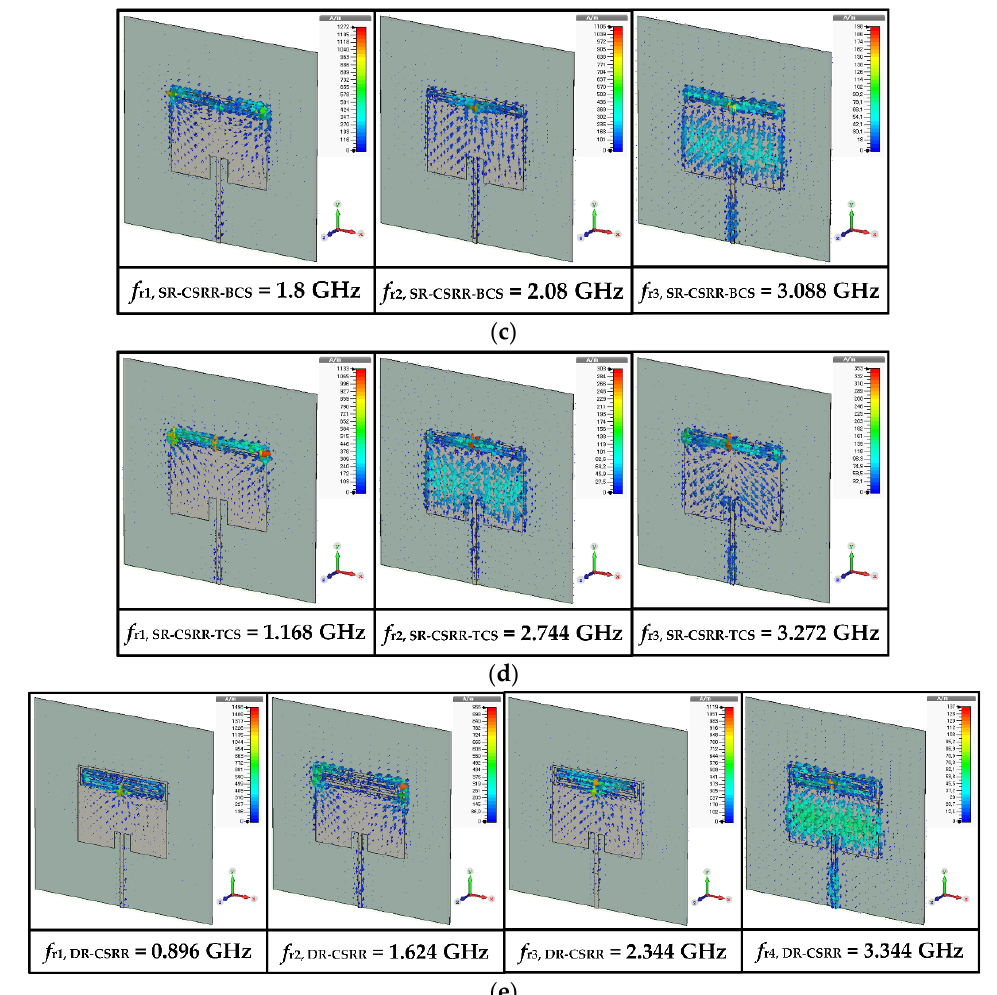
Figure 4. Simulated surface current distributions of the reference and four slot ‐ loaded MPAs at the resonant frequencies with a broadside direction (+ z axis) radiation patterns: ( a ) the reference MPA, ( b ) the RS ‐ loaded MPA, ( c ) the SR ‐ CSRR ‐ BCS slot ‐ loaded MPA, ( d ) the SR ‐ CSRR ‐ TCS slot ‐ loaded MPA, and ( e ) the DR ‐ CSRR slot ‐ loaded MPA.